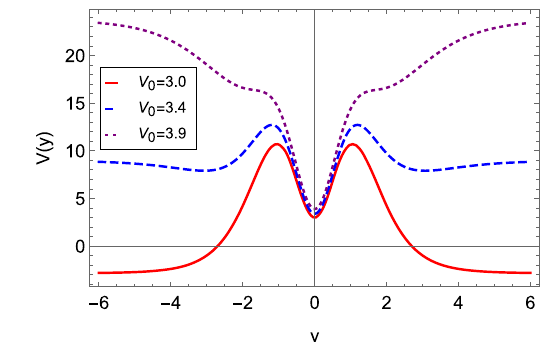
is visible that there is a transition in the behavior of V ( y ) depending on V 0 . In the right panel, we provide the solutions with V 0 = 3 . 0, V 0 = 3 . 4 and V 0 = 3 . 9 for a more detailed view of this transition